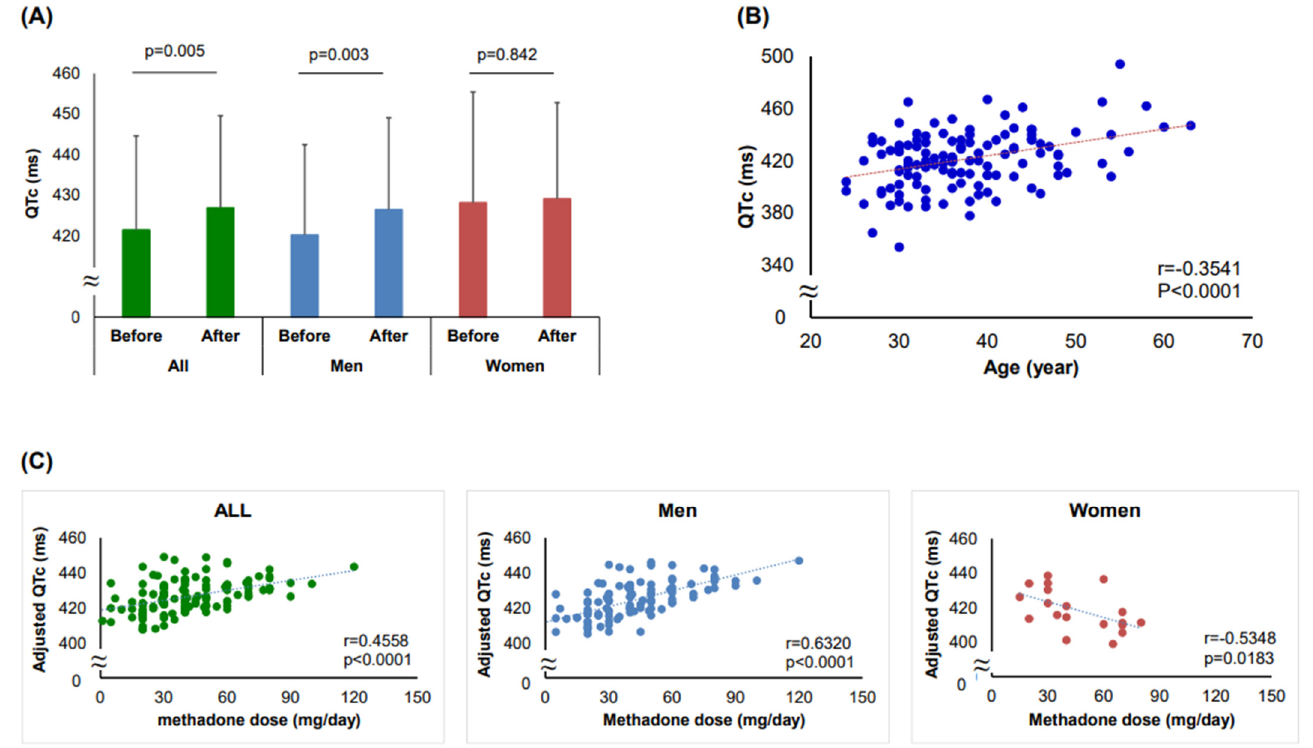
Figure 1. Effects of methadone maintenance treatment, methadone dose, and age on QTc inter- vals. ( A ) In Cohort 1, the QTc intervals significantly prolonged compared to the baseline values after methadone treatment in total (427 ± 22.7 vs. 421 ± 23.2 ms, p = 0.005) and in male patients (426 ± 22.6 vs. 420 ± 22.3 ms, p = 0.003), but not in female patients (429 ± 23.7 vs. 428 ± 27.2 ms, p = 0.842). ( B ) A significant positive correlation between age and QTc interval was observed before the administra- tion of methadone in Cohort 1 patients. ( C ) During maintenance methadone treatment, we found a significant positive correlation between methadone dose and the age-adjusted QTc interval was ob- served in total and in male patients, but a negative correlation in females.